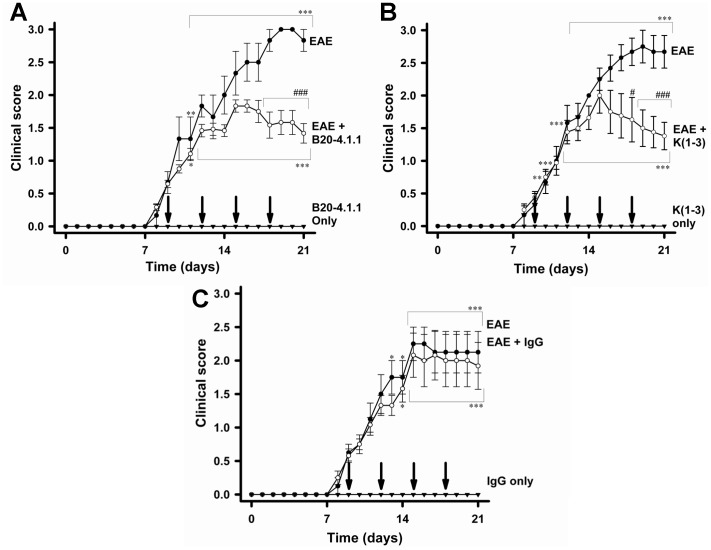
B20-4.1.1 and K(1-3) Reduce Clinical Scores in EAE.A. EAE treated with B20-4.1.1. B. Treatment with K(1-3). C. Treatment with IgG. Arrows indicate treatment days. Data shown are mean ± standard error of the mean (SEM). Indicated significance is either relative to control (*–***; P<0.05–0.001) or else compares untreated EAE with treated EAE (#,###; P<0.05, 0.001). Number of mice (n): B20-4.1.1 group: EAE only, n = 3, treated group, n = 24 up to day 14, 12 after day 14, B20-4.1.1 only, n = 3. K(1-3) group: EAE only: n = 6, treated group, n = 16 up to day 14, 8 after day 14, K(1-3) only, n = 4; IgG group: EAE only: n = 4, IgG treated, n = 12 up to day 14, 6 after day 14, IgG only, n = 2.